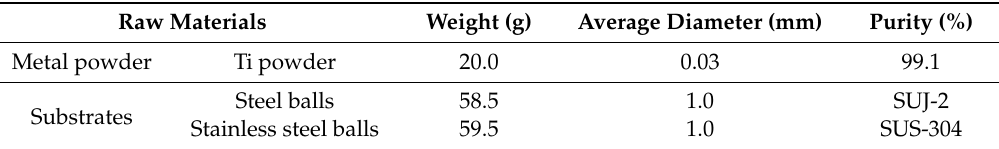
Table 2. Relevant processing parameters in the present